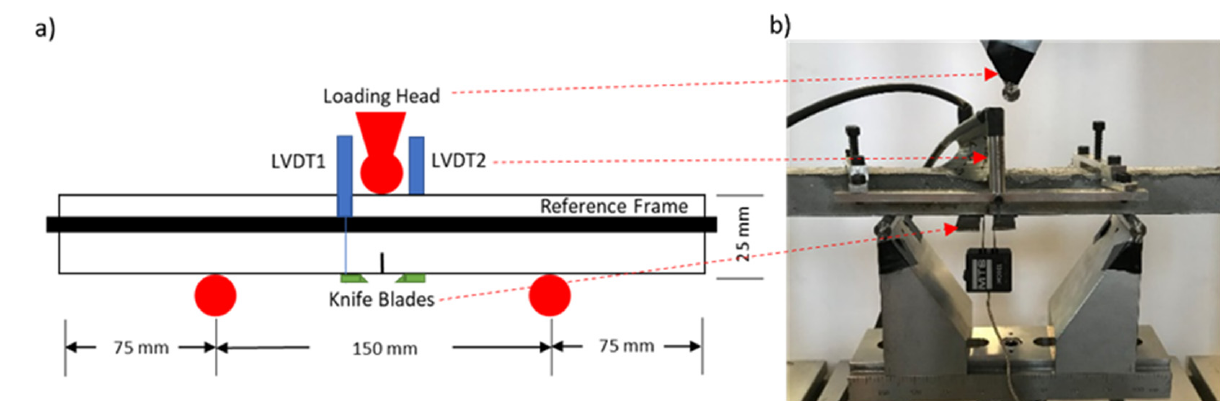
7 of 21 Figure 3. Schematic representation of the flowability test. 2.4. Uniaxial Compression Test For each mix, five cylinders of 50.8 mm diameter and 101.6 mm height were tested for compressive strength at 7 and 28 days of age. The tested cylinders were capped with sulfur as per ASTM C1231/C1231M-15 [56]. The testing was performed on the Tinius Ol- sen machine with a 4.45 N resolution and ±1778 kN range at a rate of 1 mm/min [57]. 2.5. Modulus of Rupture Test For each mix, five unnotched prisms of 25 mm × 25 mm × 300 mm were tested in three-point bending to determine the modulus of rupture (MoR) and the elastic modulus 𝐸 (cid:3022)(cid:3015) for each of the six mixes at 7 and 28 days of age. Each prism’s loading span was 150 mm with a symmetric double cantilever to counter the effect of self-weight [58,59]. Two linear variable differential transformers (LVDTs) were mounted on the reference frame, as shown in Figure 4, at a distance 10 mm from the prism center to record vertical defor- mations. The loading rate was 0.05 mm/min on the MTS Bionix Servohydraulic Machine (MTS, Eden Prairie, MN, USA), with 1 N resolution and ±25 kN range. The MoR was cal- culated based on the peak load of each unnotched specimen. The elastic modulus 𝐸 (cid:3022)(cid:3015) was calculated using Equation (1) [60,61]. To improve elastic modulus evaluation accu-